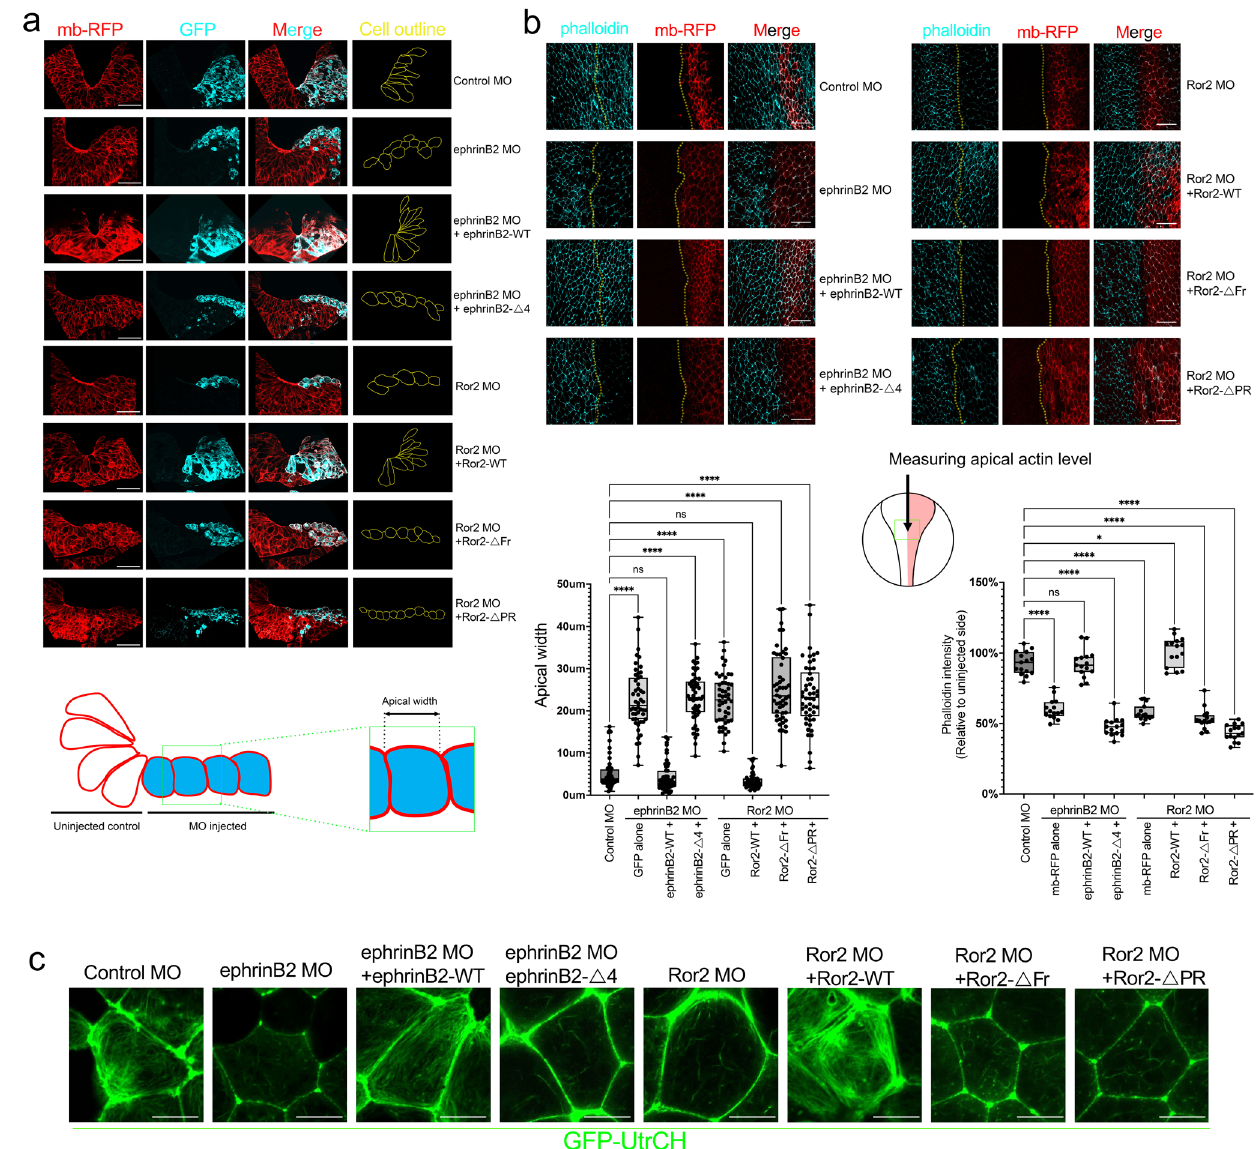
Fig. 2 | ephrinB2/Ror2 interaction regulates contractile actin network forma- tion. a Transverse section through the neural plate. Unilateral injection of MO (2ng) and RNA (ephrinB2s; 25pg, Ror2s; 50pg) as indicated. Membrane-RFP (100pg) labeled outline of the neural plate cells. GFP (50pg) indicates the MO- injected side. The box plot shows Min to Max with all data points. Numbers of embryos/experiments: 50/5 for each column. One-way ANOVAs followed by Dun- nett ’ s multiple comparison tests were used ( p -value<0.0001). n.s., not signi fi cant, **** p <0.0001. Scale bar, 500 μ m. Schematic of measuring apical width. Scale bar,